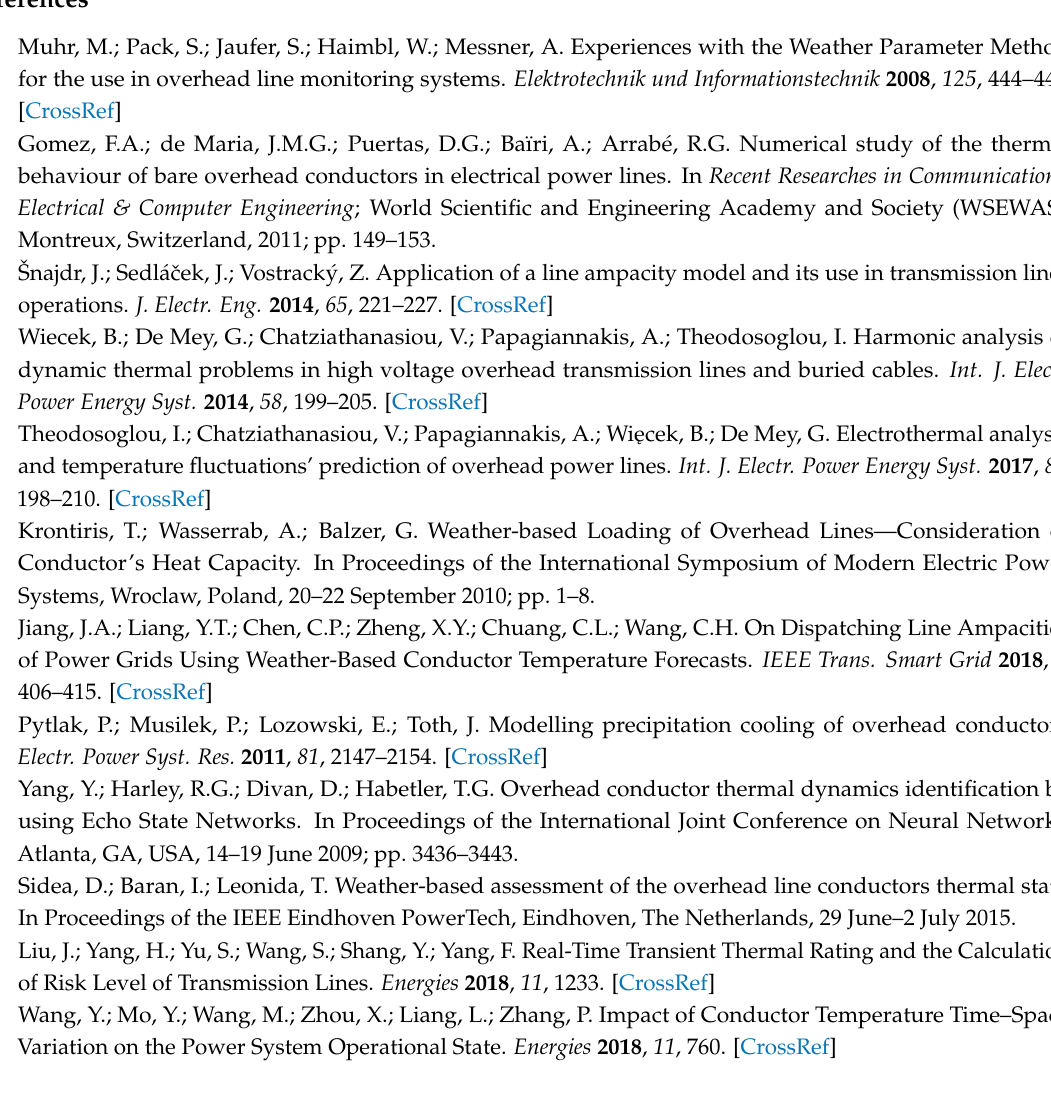
Table S1: An example of the input data